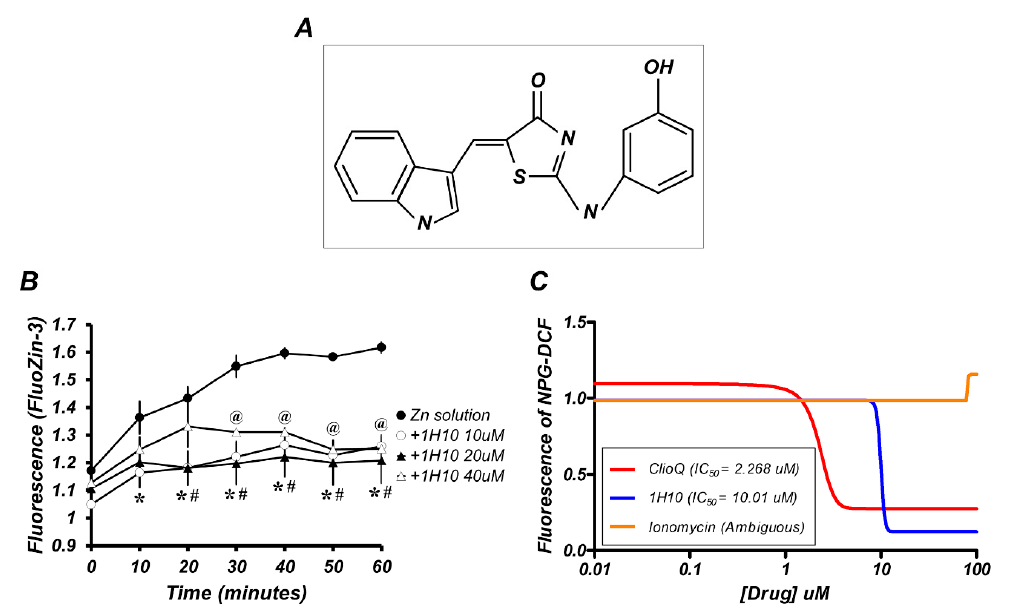
Figure 1. 1H10 has a zinc-chelating capacity. ( A ) Chemical structure of 1H10. ( B ) FluoZin-3 fluorescence level was measured at the indicated time points after 15 min of exposure to 300 μ m zinc with or without the three different concentrations of 1H10 (10, 20, or 40 μ M) in mouse neuronal cultures. Data are mean ± SEM ( n = 3). @ , # , and *: p < 0.05 versus zinc alone at the same time point (unpaired Student’s t -test). ( C ) In the test tubes, the fluorescence of Newport Green DCF (NPG-DCF, 0.1 μ M) was estimated after a 30-min incubation of zinc (20 μ M) with or without the drugs (ClioQ; clioquinol, 1H10, or ionomycin) at the different doses (0, 0.2, 0.6, 2, 10, 20, 40, or 100 μ M). The half maximal inhibitory concentration (IC 50 ) was calculated by Prism 5.